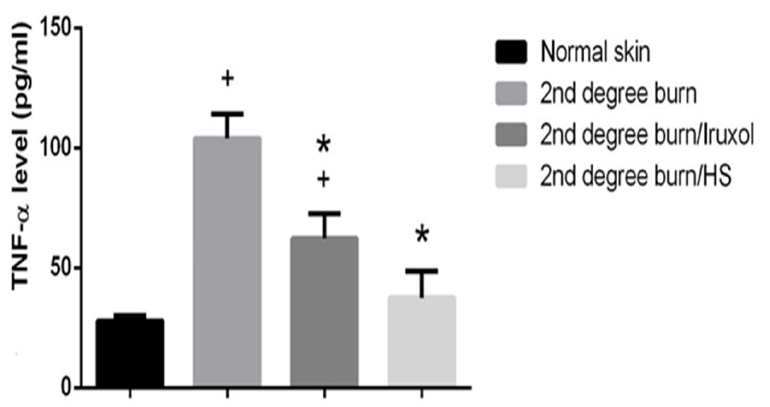
Figure 6. Effect of HS on TNF- α . TNF- α : Tumor necrosis factor alpha; HS: Hibiscus sabdariffa ; +, ( p < 0.05) vs. normal group; *, ( p < 0.05) vs. 2nd degree burn group. Differences between groups were examined by ANOVA/Tukey/Kramer’s multiple comparison test. n = 6.